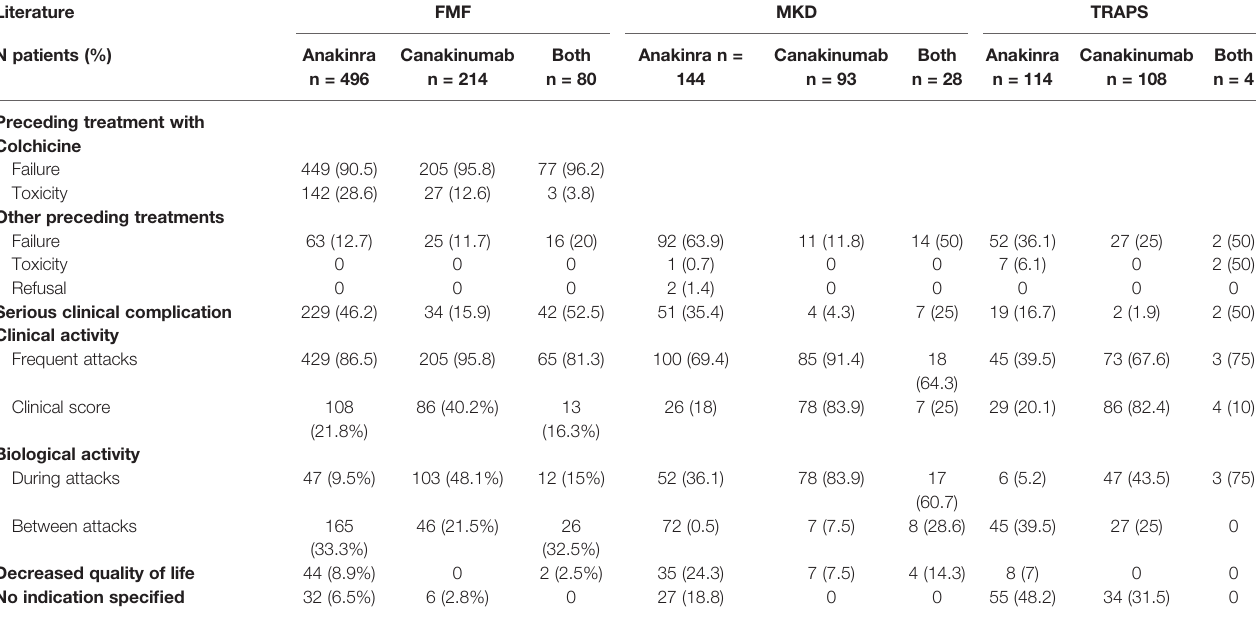
TABLE 3 | IL-1 blockers ’ indications: literature review (population N = 1,210). IL, interleukin; FMF, familial Mediterranean fever; MKD, mevalonate kinase de fi ciency; TRAPS, tumor necrosis factor receptor-associated periodic